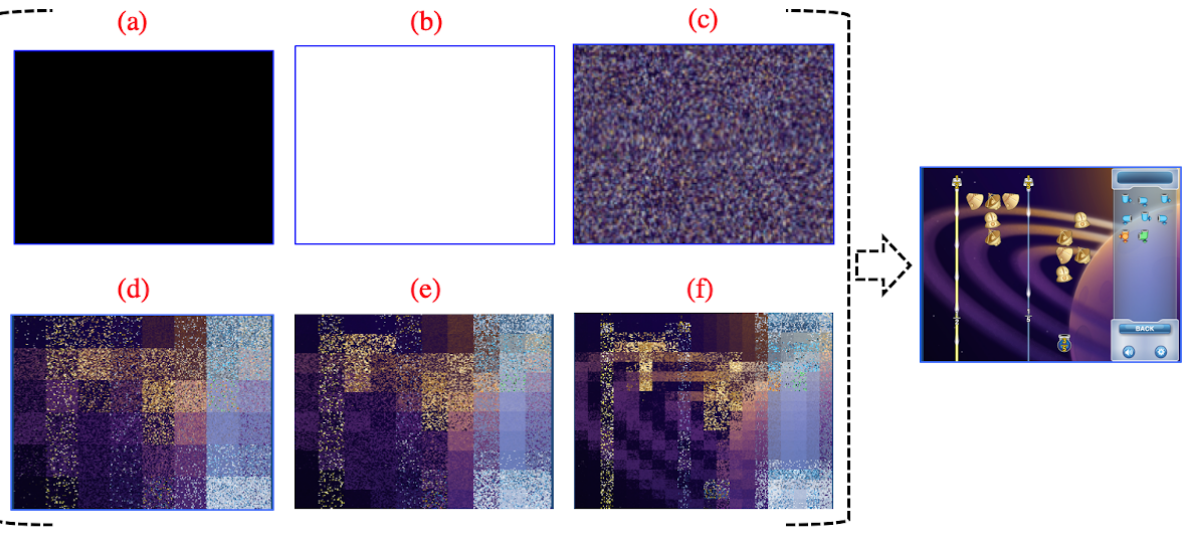
Figure 3. Baseline images tested. (Left) Baseline images can be uniform such as (a) black and (b) white, or can depend on the initial image like (c)